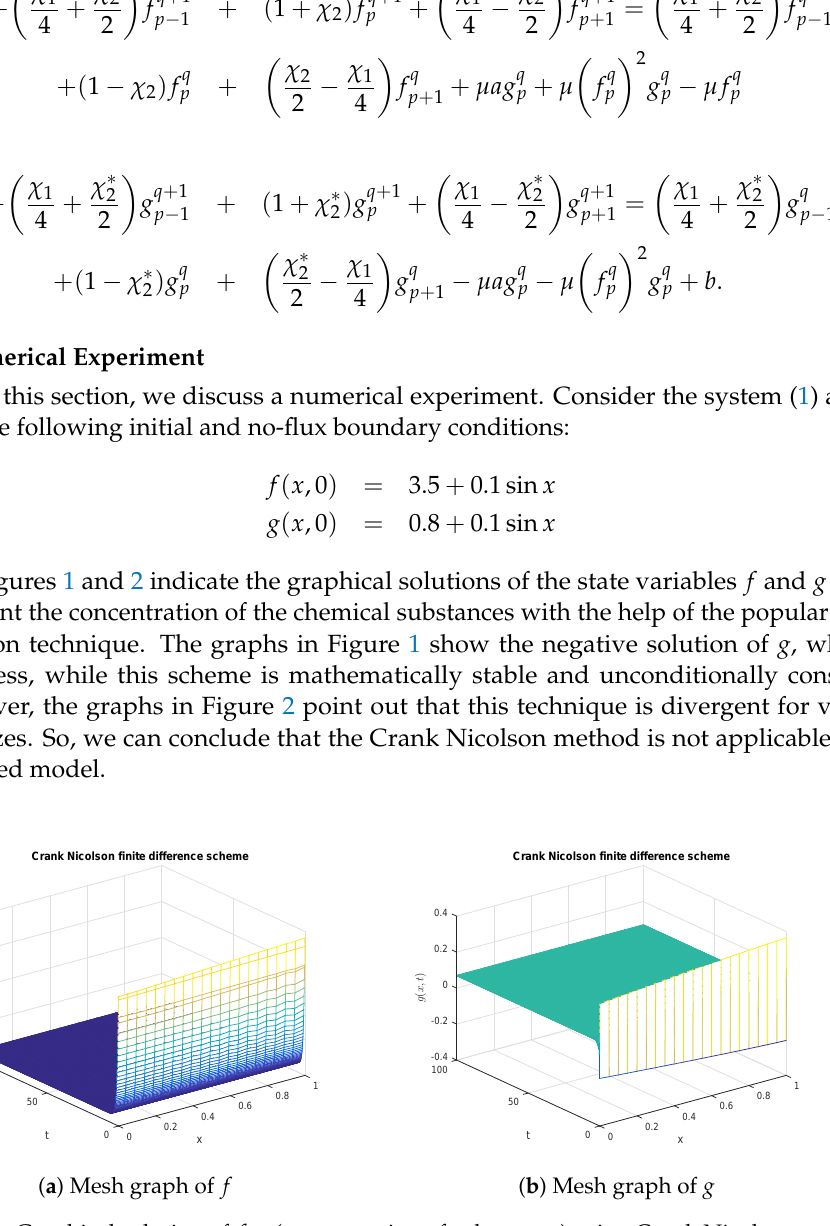
= 0.04 ν = ν = 10 − 3 2 1 2